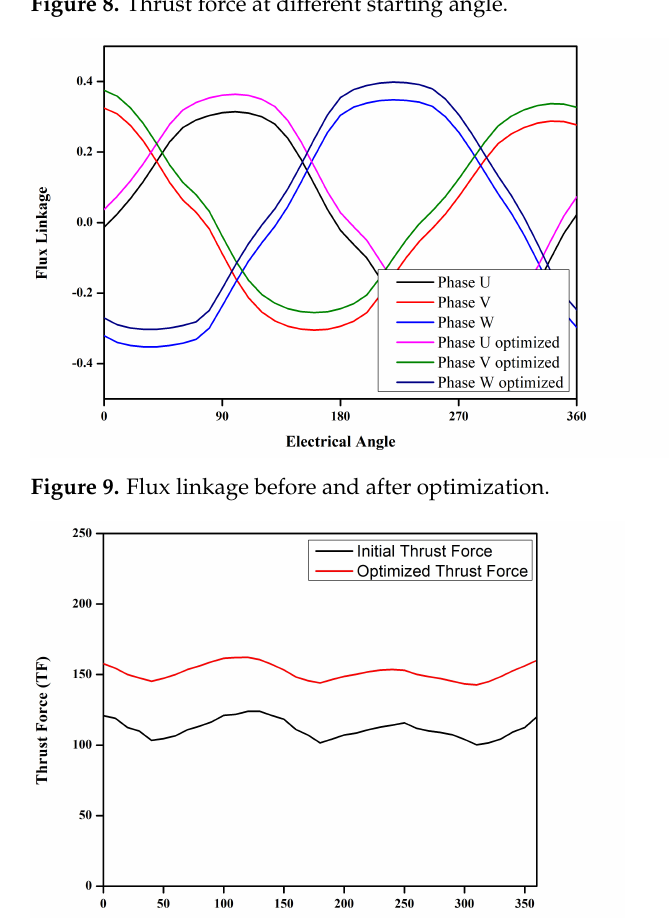
Figure 8. Thrust force at different starting angle.